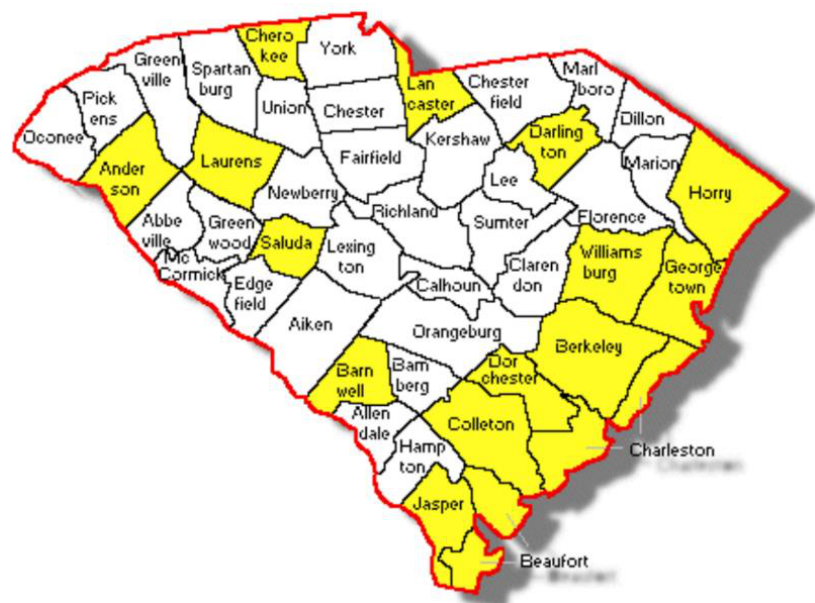
Figure 3. South Carolina counties served by the HPV Vaccination Van Program. Table 1. Vaccinations and their